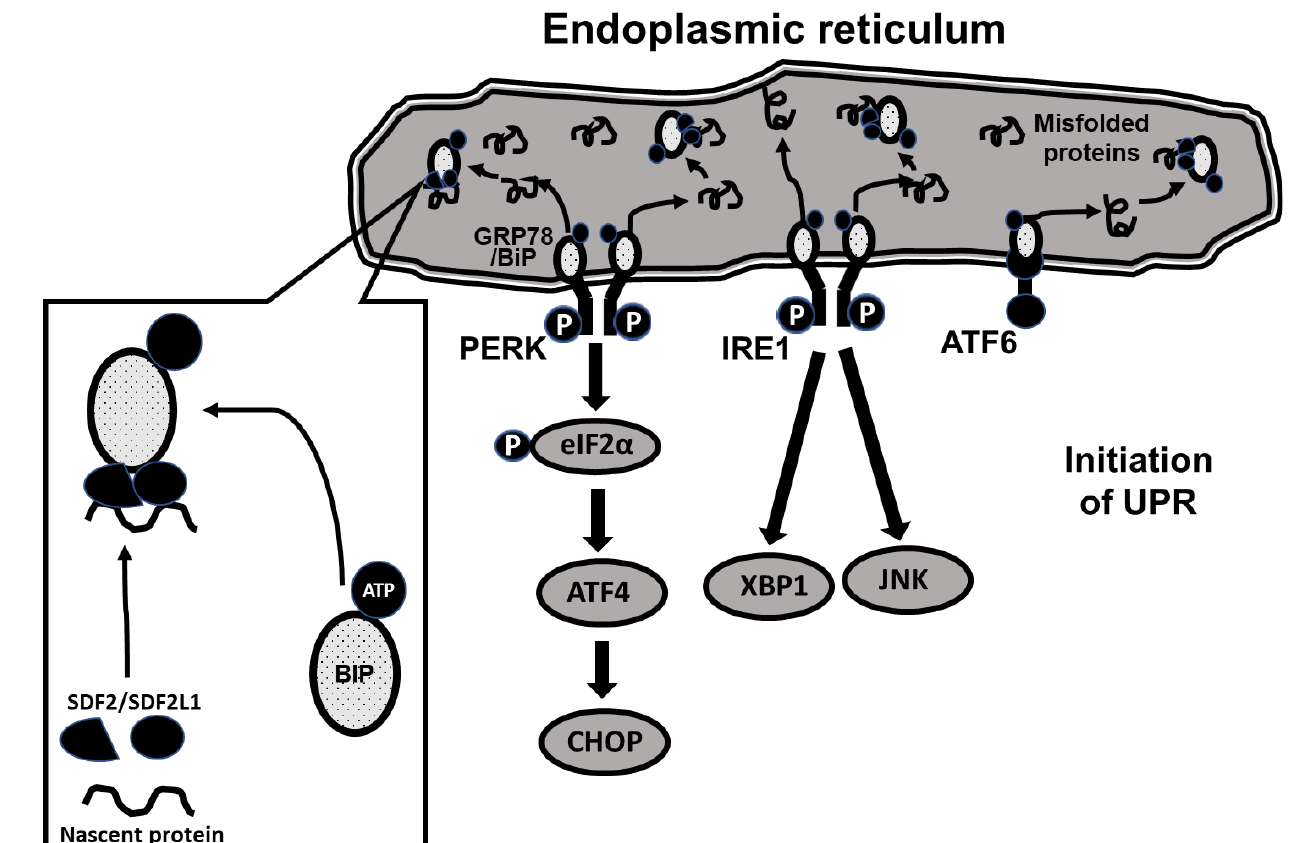
Figure 1. Scheme of the unfolded protein response (UPR) in the endoplasmic reticulum (ER). UPR is initiated through 3 ER-resident membrane-bound proteins, protein kinase RNA-like ER kinase (PERK), inositol requiring enzyme 1 (IRE1) and activating transcription factor 6 (ATF6). Under base- line conditions, PERK, IRE1 and ATF6 are coupled to a binding immunoglobulin protein (BIP/GRP78) that holds them in an inactive state on the ER membrane. During increased protein synthesis misfolded proteins accumulate in the ER. In response, BiP is released from the membrane proteins and the PERK, IRE1 and ATF6 pathways are triggered, initiating the unfolded protein response. The release of BiP from the membrane-bound proteins is enabled by associating with three additional ER-resident proteins, ERdj3, SDF2 (constitutively expressed) and SDF2L1 (expression induced during ER stress), the resulting complex inhibiting further aggregation and accumulation of misfolded proteins. The key proteins involved in the activation of the PERK pathway are the eukaryotic initiation factor 2α (eIF2α), followed downstream by the activating transcription factor 4 (ATF4) and the C/EBP homologous protein (CHOP) and of the IRE1 pathway the X box binding protein 1 (XBP-1) and the c-Jun N-terminal kinase protein